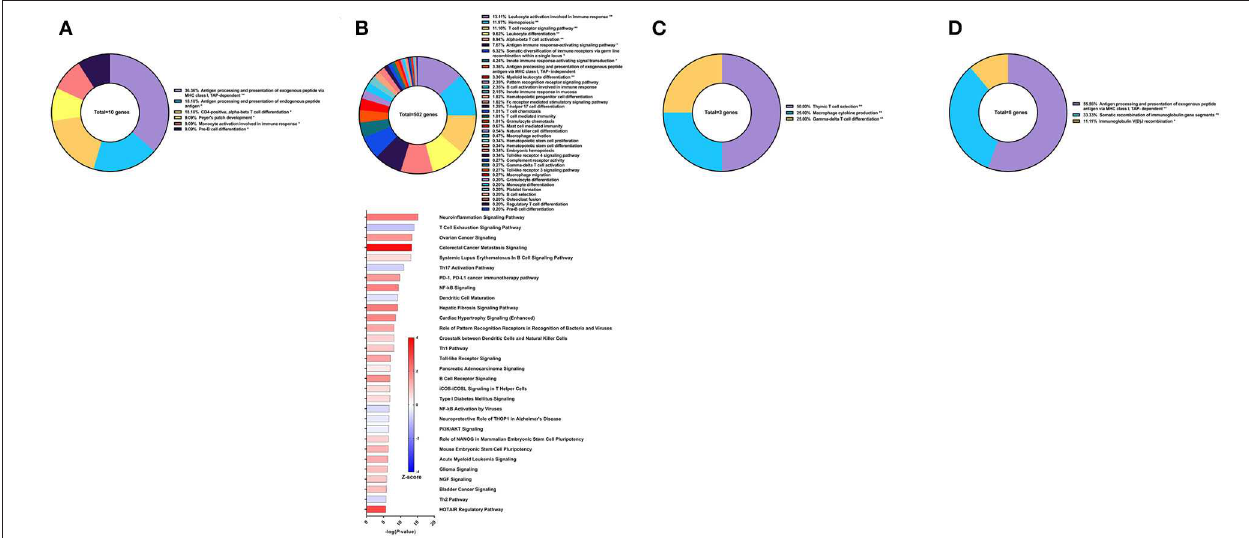
FIGURE 8 | RNA-Seq analysis of rSm-p80 + GLA-Alum, a recombinant protein vaccine strategy. (A) PBMCs after vaccination (Top) Gene ontology enrichment analysis represented as a pie graph of percentages of genes per group out of a total number of differentially expressed genes. “**” and “*” indicates P < 0.05 and P < 0.01, respectively. (Bottom) Canonical pathway analysis generated using IPA. Bars are plotted based on the – log10( P -value) and colored based on predicted activation (red) and deactivation/inhibition (blue) according to the Z-score, a composite assessment based on the degree of overlap between directional expression of genes from the observed data and the Qiagen-curated public database. The top 30 pathways are shown based on the lowest P -values. (B) PBMCs after challenge (Top) Gene ontology enrichment analysis. (Bottom) Canonical pathway analysis generated using IPA. (C) Spleen cells (Top) Gene ontology enrichment analysis. (Bottom) Canonical pathway analysis generated using IPA. (D) Mesenteric lymph node cells (Top) Gene ontology enrichment analysis. (Bottom) Canonical pathway analysis generated using IPA.